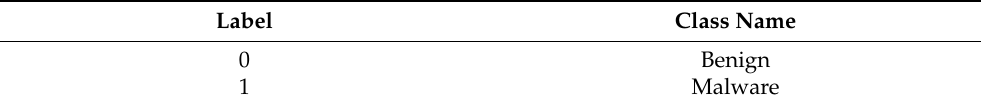
Table 4. Class name and numeric